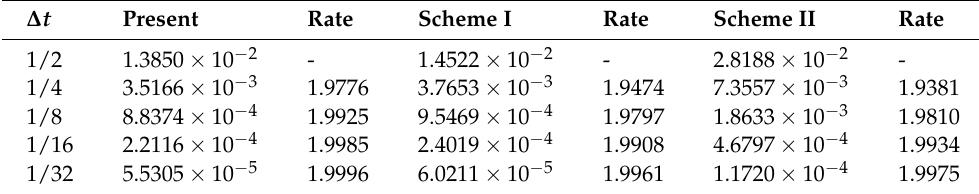
Table 3. Error comparison and temporal convergence orders in (cid:107) · (cid:107) ∞ -norm using ∆ t = h at T = 10. ∆ t Present Rate